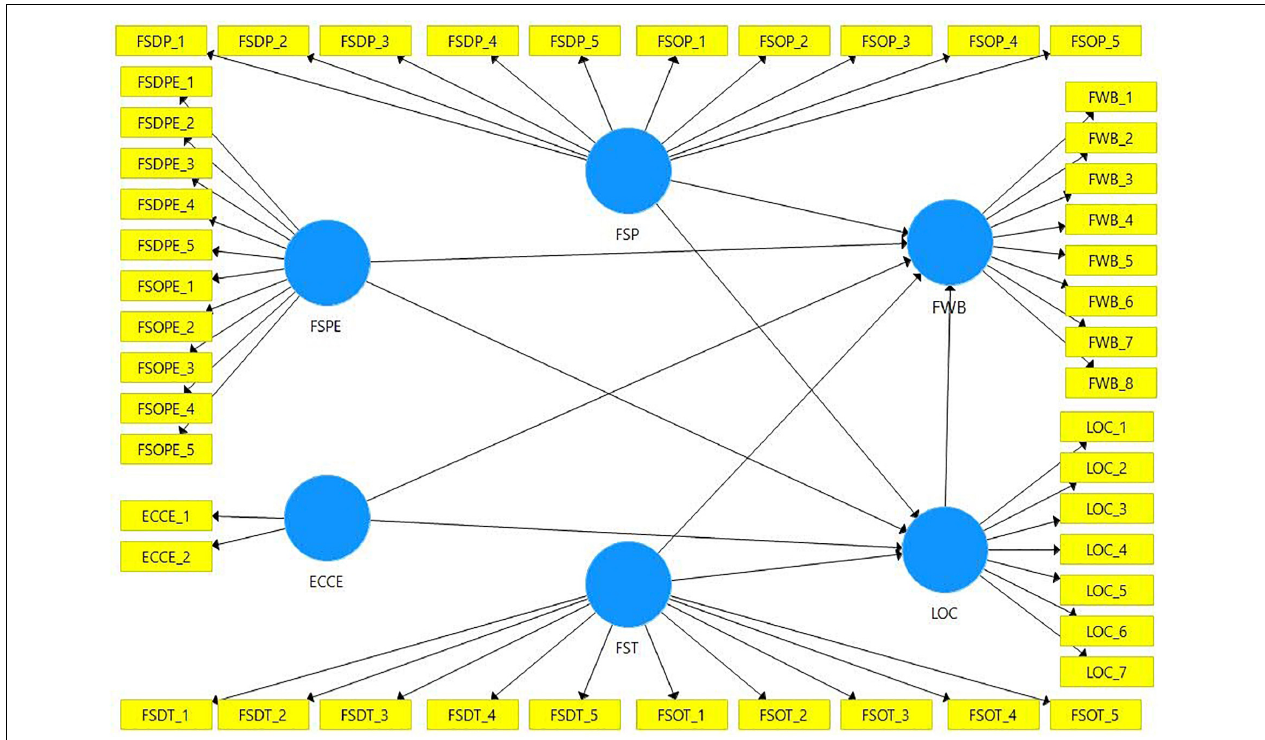
FIGURE 1 | Theoretical